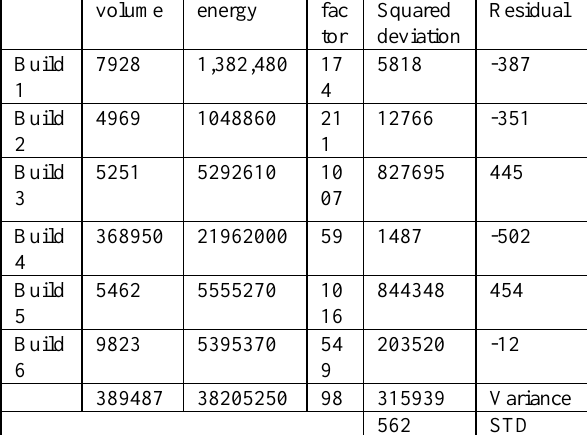
Table 3 Larger Sample of Statistic for averaging energy